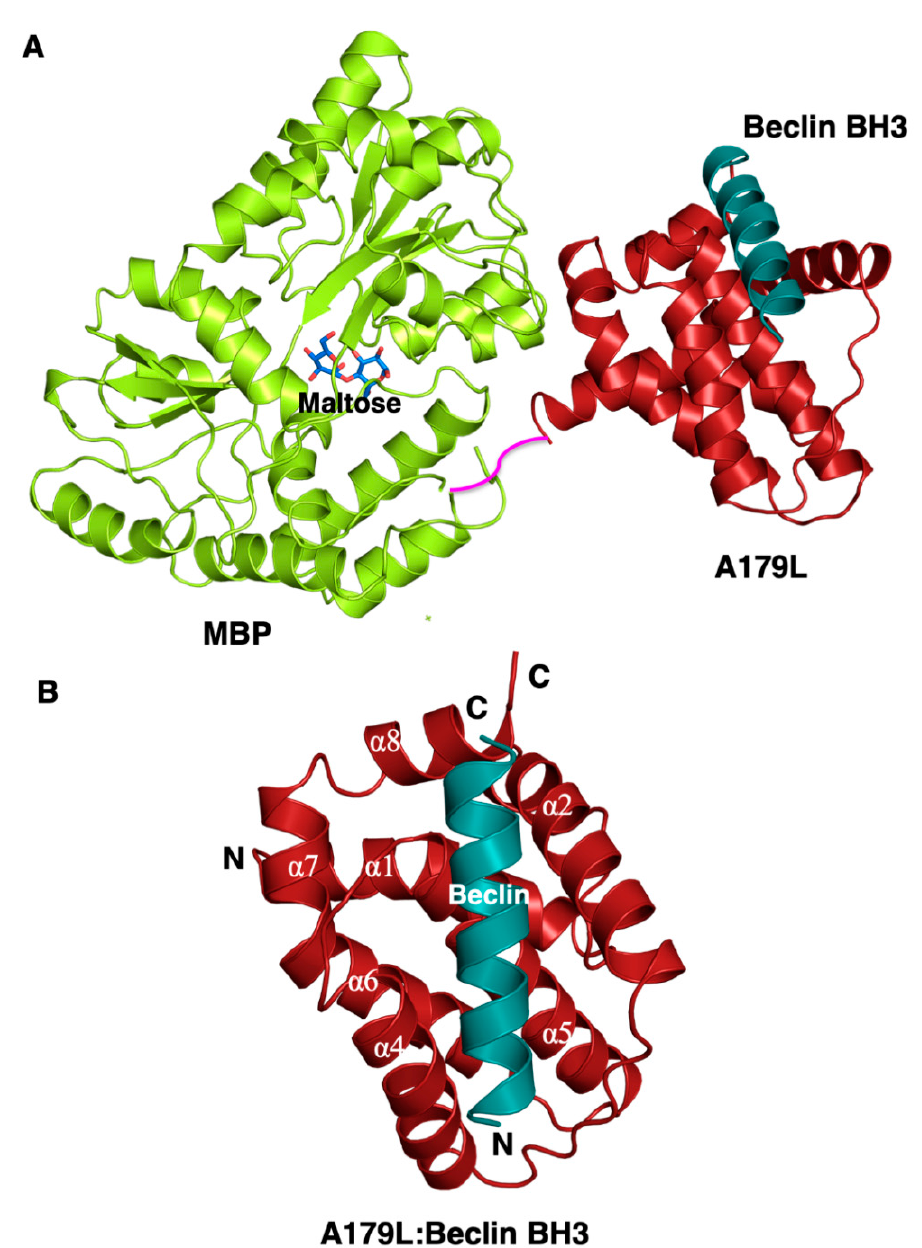
Figure 1. Crystal structure of A179L:Beclin BH3. ( A ) Crystal structure of maltose-binding protein (MBP) fusion (green limon) in complex with maltose (blue sticks) fused at the N-terminus of A179L (red firebrick) in complex with a peptide spanning the BH3 motif of Beclin (cyan). A short linker comprising the residues NSSS lacking electron density between MBP and A179L is shown in magenta and was modelled by hand. ( B ) The conserved Bcl-2 fold of A179L comprising 8 α -helices with the Beclin BH3 peptide bound in the hydrophobic groove formed by α 2-5. Helix names have been retained to be identical to those of the Bcl-x L :BH3 Beclin complex (PDB ID:2P1L) [55].